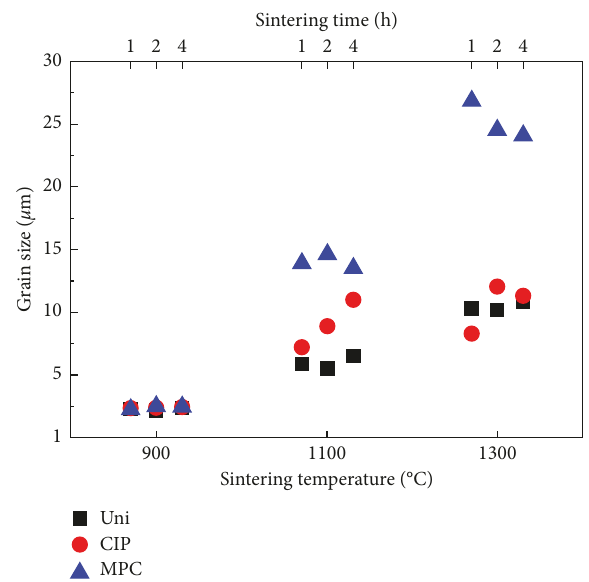
Figure 3: Variations in the grain sizes of the sintered ZnO ceramics prepared using the three compacting methods (uniaxial pressing, CIP, and MPC) with respect to the sintering temperature and